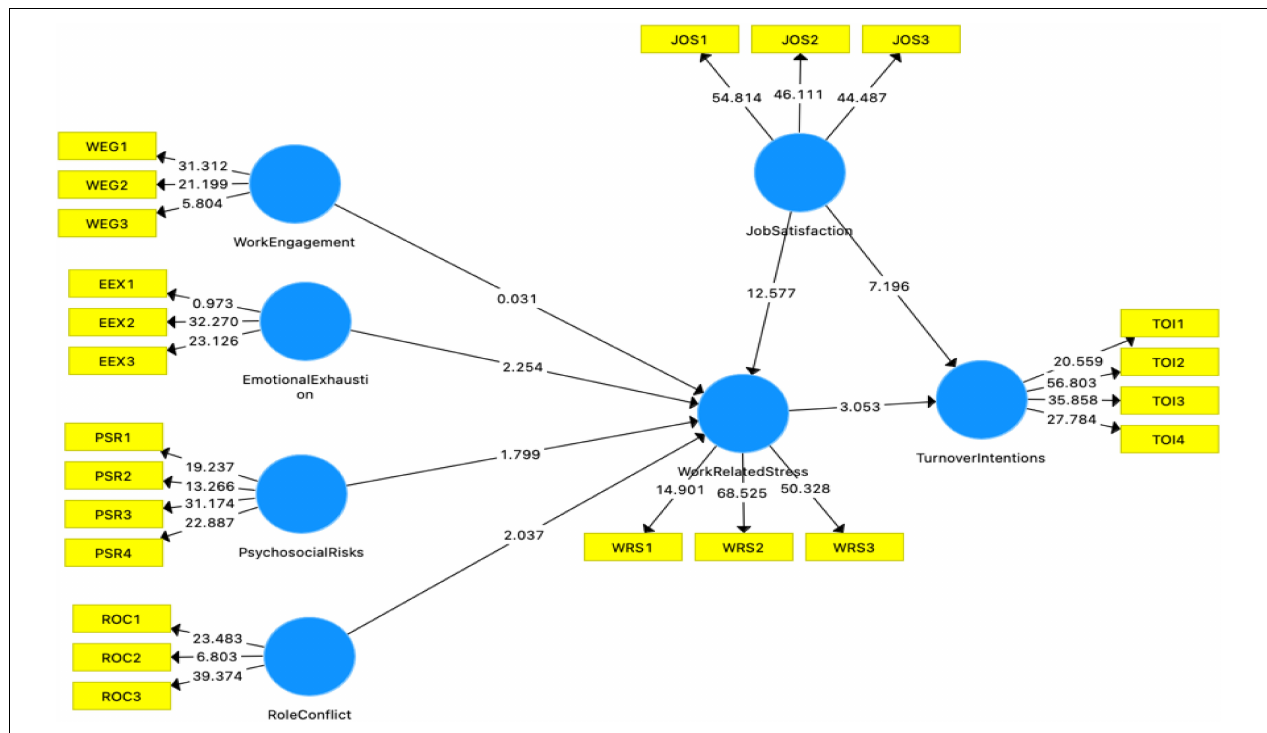
FIGURE 2 | Structural equation